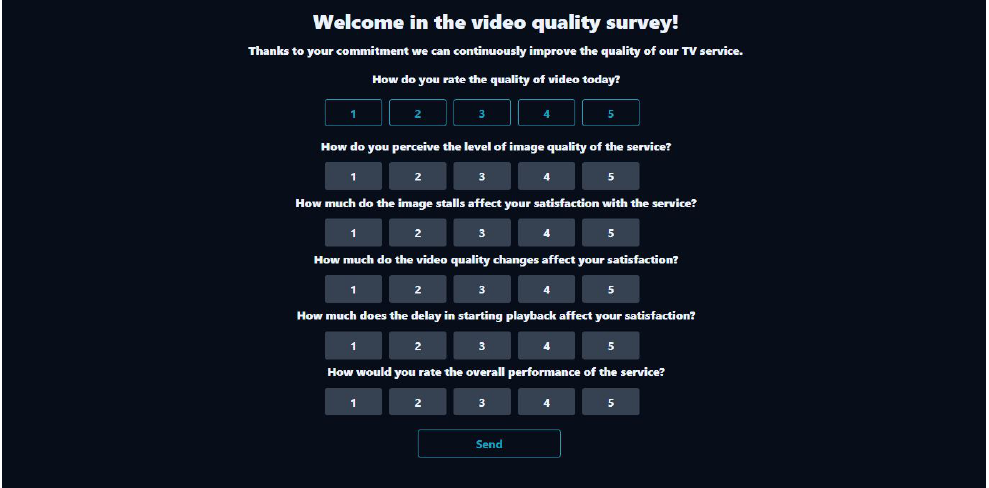
Figure 16. Application displayed on STBs that contains survey for video quality assessment and label